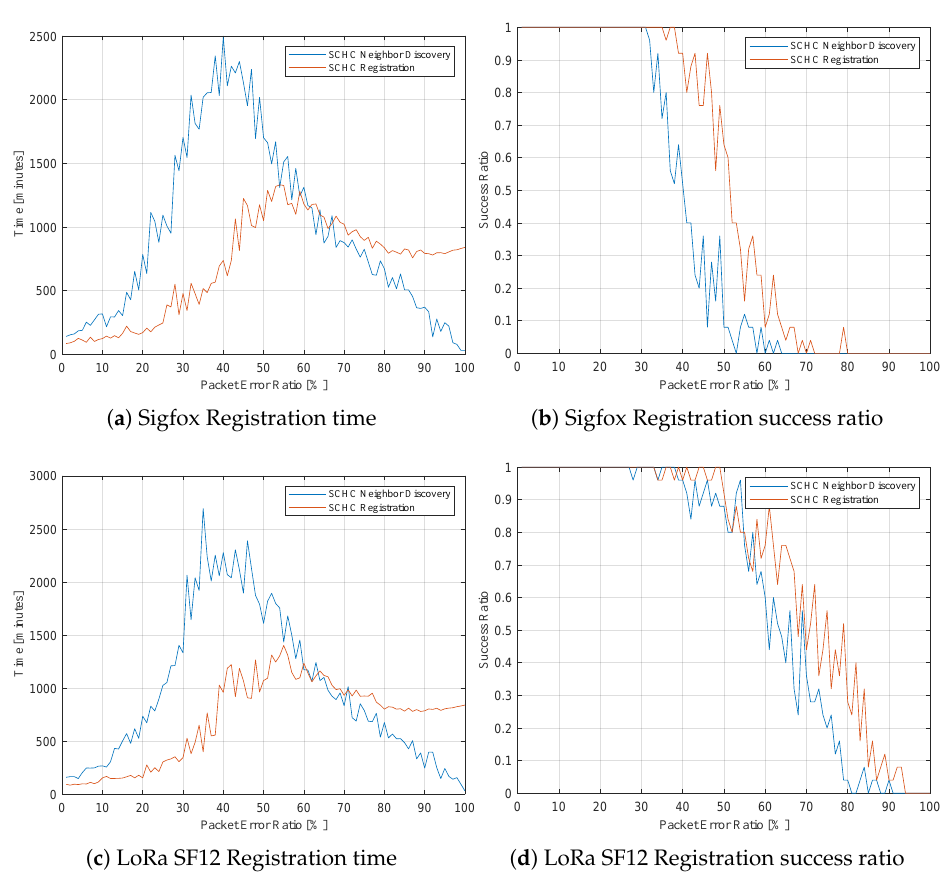
Figure 14. Registration time for different packet error ratios